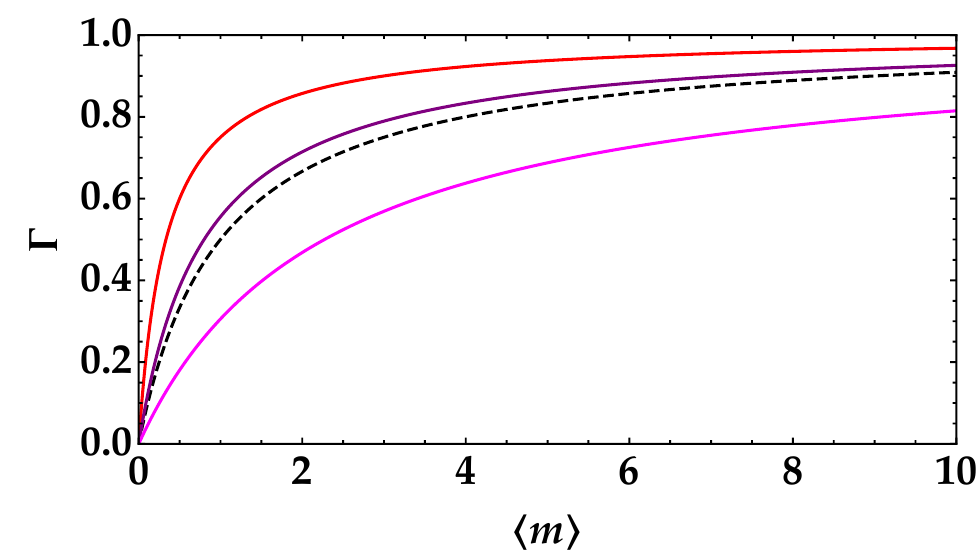
Figure 2. Cross-correlation coefficient Γ as a function of the mean number of detected photons at each of the outputs of the BS for different values of µ f and µ s . From top to bottom, red curve: µ f = 1 and µ s = 1; purple curve: µ f = 2 and µ s = 2; magenta curve: µ f = 5 and µ s = 5; dashed black curve: µ = 1 for single-mode thermal state of light.